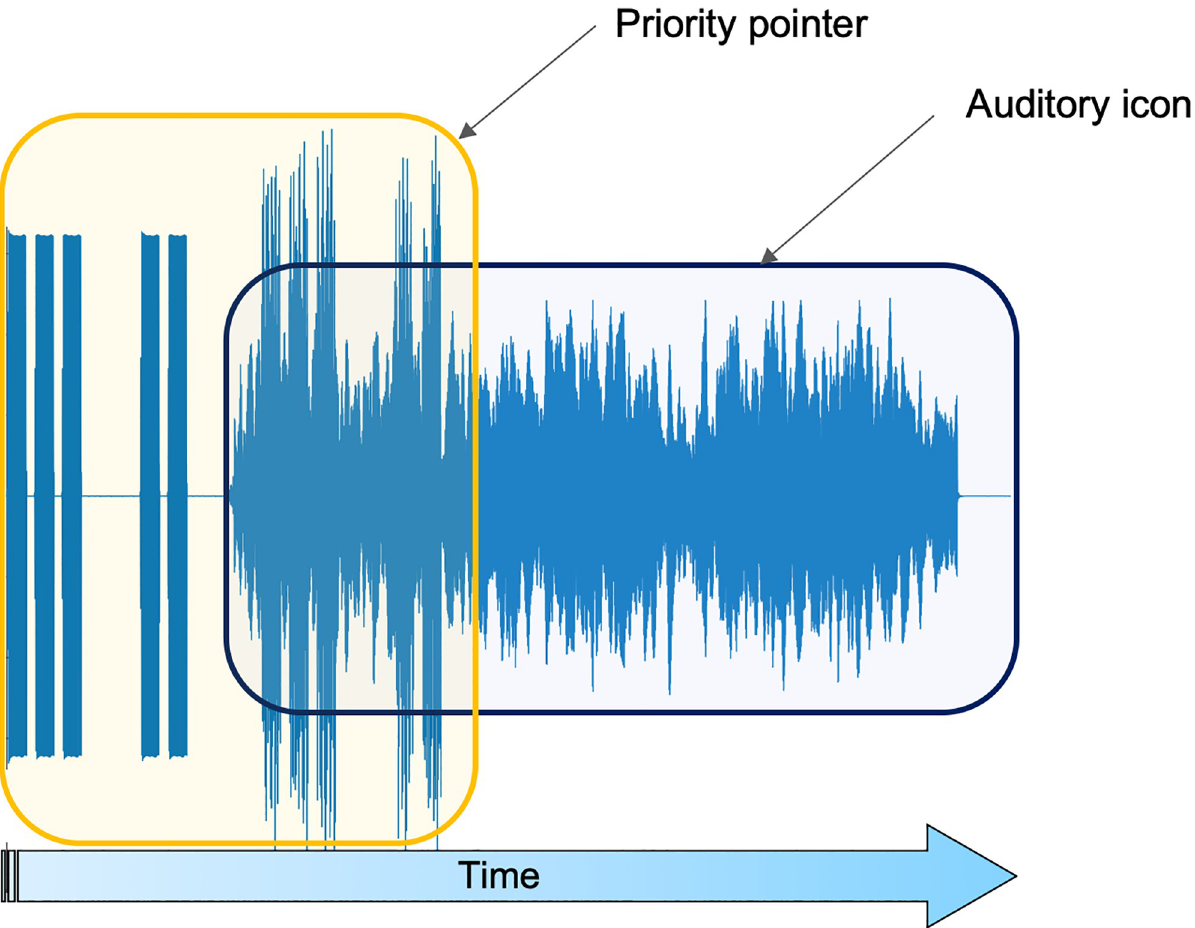
Fig 1. General structure of an alarm signal as recommended by the 2020 updated standard. The priority pointer is used to discriminate between the different urgency priorities (low, medium, and high). The auditory icon represents the alarm category.